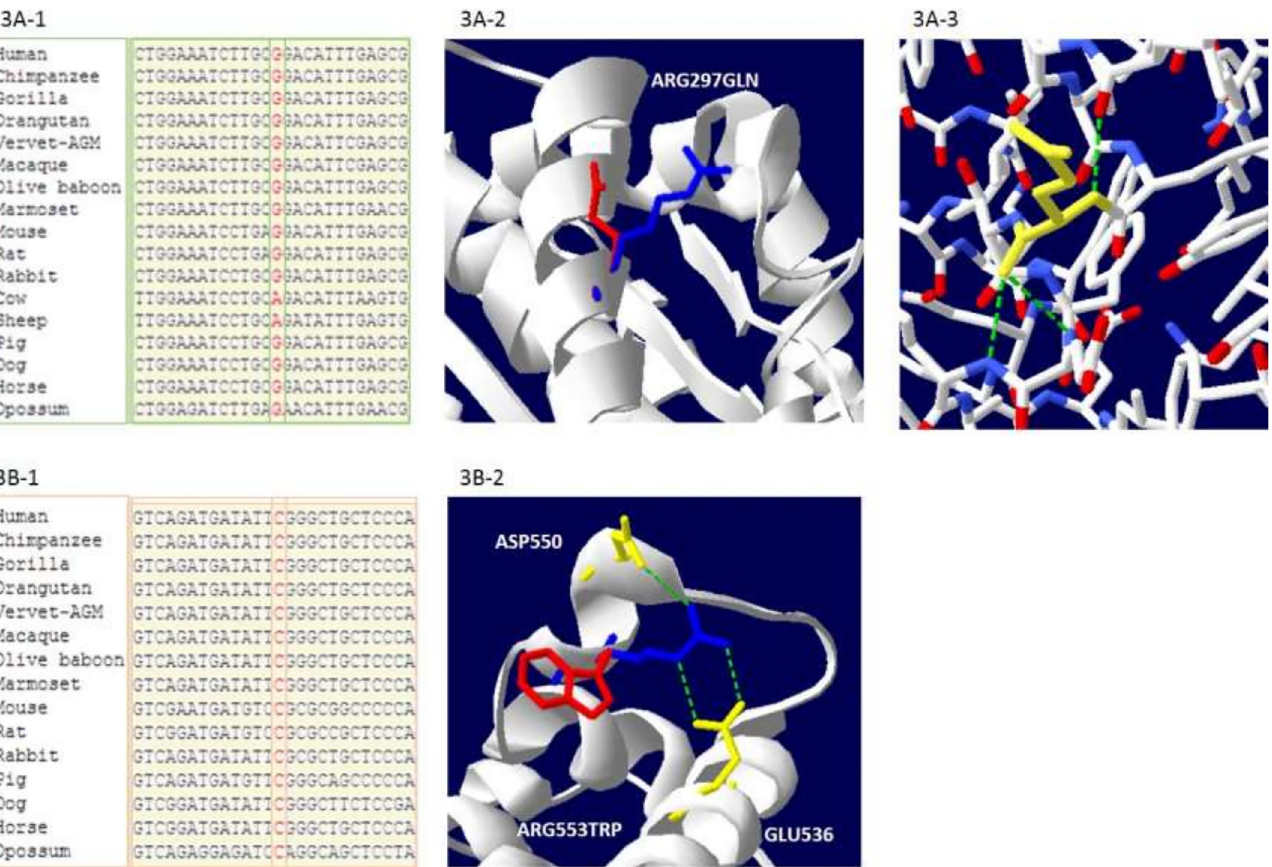
Fig 3. A-B . Fig 3A-1. Sequence alignment of 297Gln reveals partial conservation of ancestral ‘G’ allele at positionArg297 to Gln297 of the GCKR gene across species. Fig 3A-2. Protein modeling of Arg297Gln showing the wild-type blue (Arg297) and mutant red (Gln297) residues. Fig 3A-3 The wild-type Arg297 forms a salt bridge with glutamic acid at position 63 glutamic acid at position 300, however, the new mutant residue is not in the correct position to make the same hydrogen bond as the original wild-type residue did. Fig 3B-1. Sequence alignment reveals a complete conservation of wild type ‘C’ allele at position of Arg553Trp of the GCKR gene across species. Fig 3B-2. Protein modeling of and Arg 553Trp mutations in the GCKR gene. The wild-type residue (blue) forms a hydrogen bond with glutamic acid at position 536, and aspartic acid at position 550. The size difference between wild-type and mutant residue makes that the new residue is not in the correct position to make the same hydrogen bond as the original wild-type residue. The wild-type residue was positively charged, the mutant residue is neutral. The mutant residue is more hydrophobic than the wild-type residue.